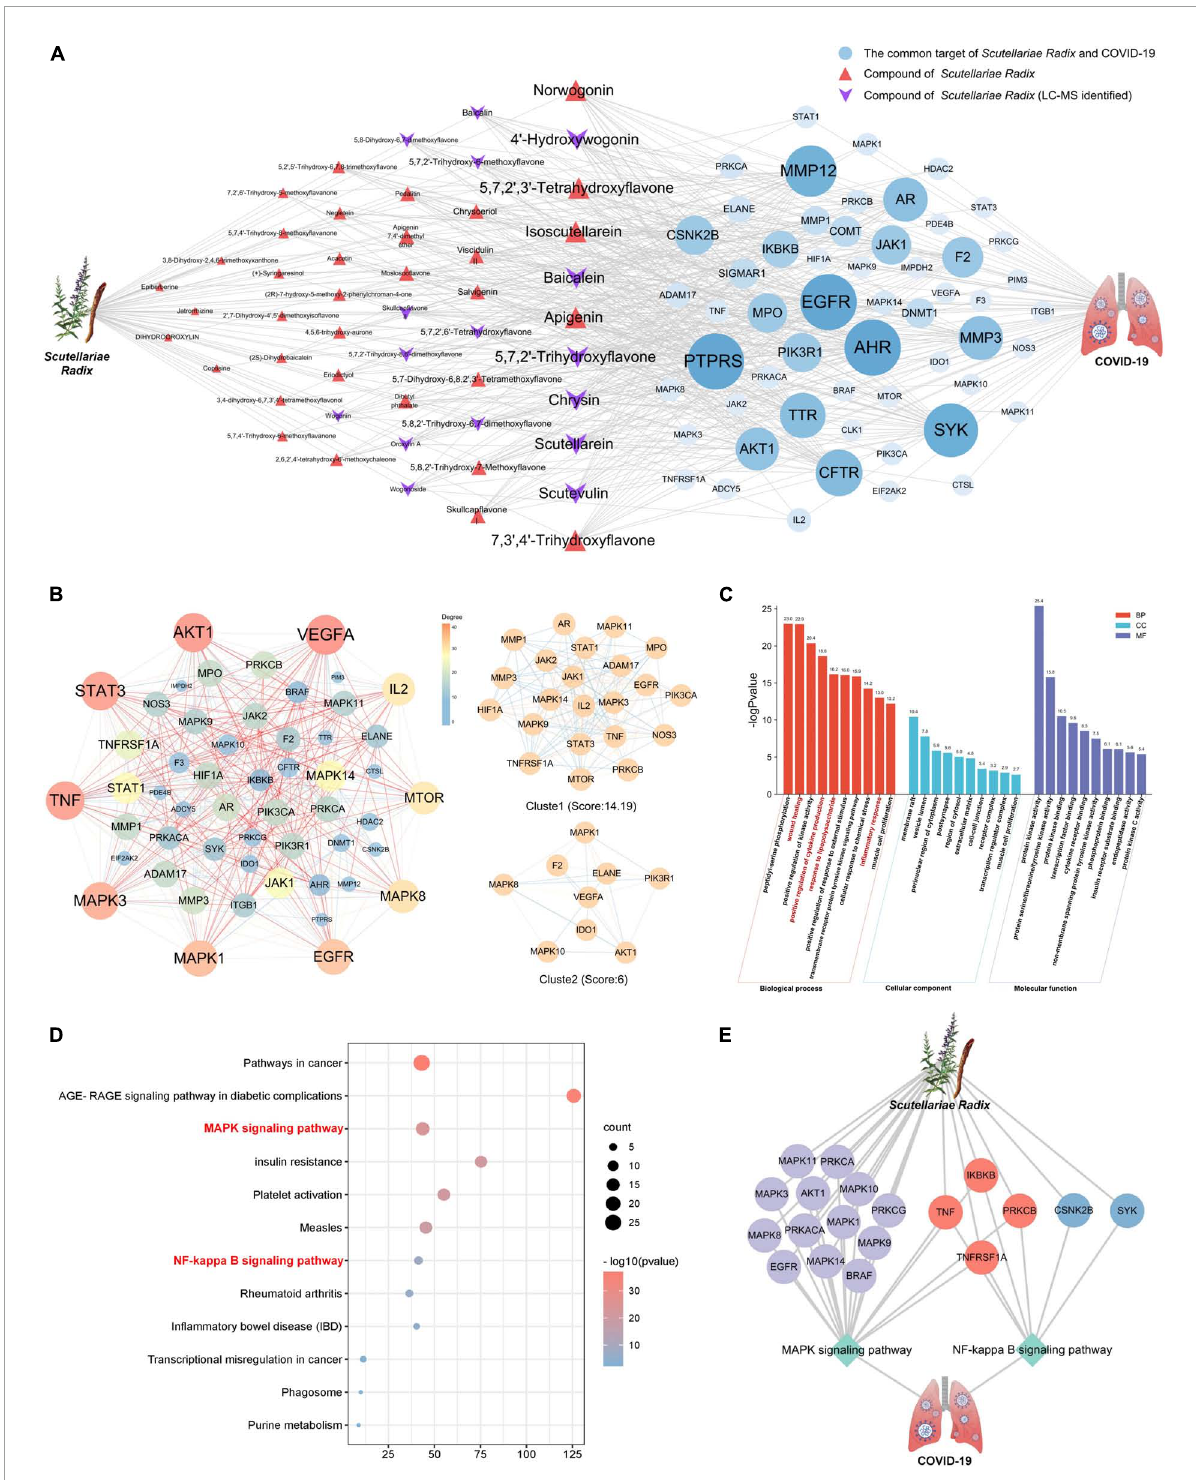
FIGURE4 Network pharmacology analysis of Scutellariae radix against COVID-19. (A) Herb-Component-Target-Disease network diagram of Scutellariae radix against COVID-19. (B) The PPI network of targets of Scutellariae radix treating COVID-19. (C) GO enrichment analysis of common targets. (D) KEGG enrichment analysis of common targets. (E) Herb-Target-Pathway-Disease network diagram of Scutellariae radix against COVID-19. Light gray represents targets in the MAPK pathway. Blue represents targets in the NF- κ B pathway. Red means the targets belong to both MAPK and NF- κ B